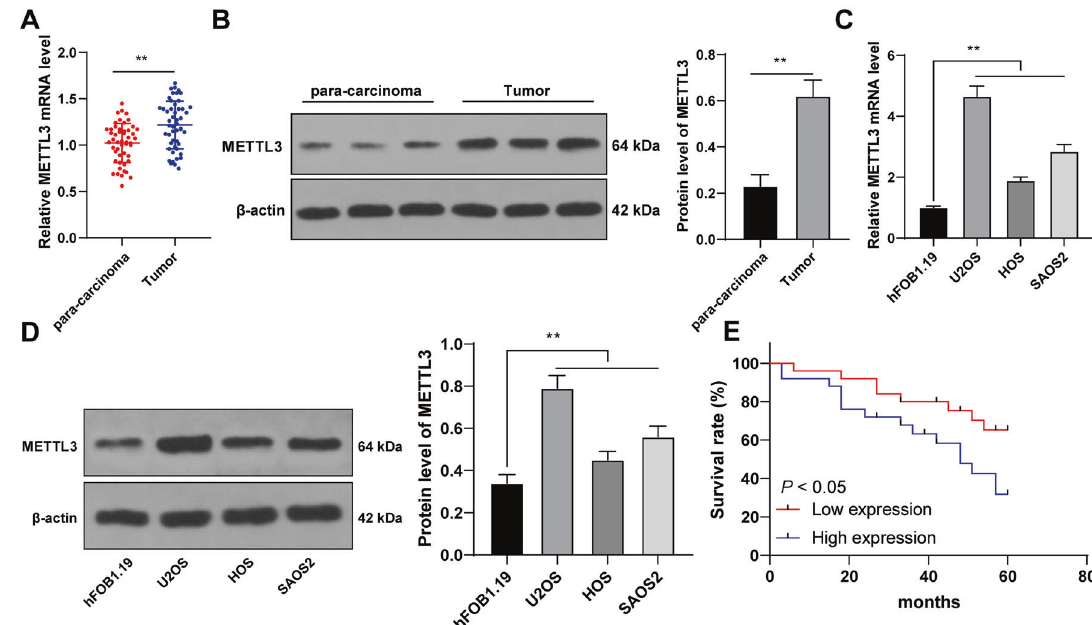
Fig. 1 METTL3 was highly expressed in OS tissues and cells and correlated with the prognosis and clinicopathological features of OS patients. A , B METTL3 expression in 50 pairs of OS tissues and adjacent tissues was detected using RT-qPCR and western blot. C , D METTL3 expression in human OS cell lines (U2OS, HOS, SAOS2) and normal osteoblasts (hFOB1.1) was detected using RT-qPCR and western blot. E With the median mRNA level of METTL3 in OS tissues as the critical value, the correlation between METTL3 mRNA level and prognosis of 50 OS patients was analyzed using Kaplan – Meier survival curve. N = 50. The cell experiment was repeated three times independently. Data in panels B – D are presented as mean ± standard deviation. Data in panel A were analyzed using paired t -test and data in panel B were analyzed using t -test. Data comparisons between two groups in panel E were analyzed using Log-Rank test and data comparisons among multiple groups in panels C , D were analyzed using one-way ANOVA, followed by Tukey ’ s multiple comparisons test, ** p <